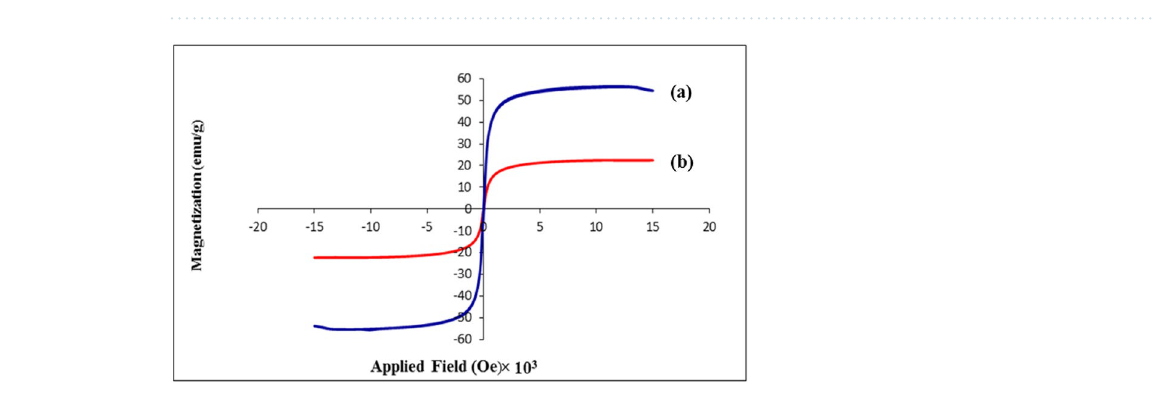
Figure 4. TEM images of Fe 3 O 4 @SiO 2 -creatine nanobiocatalyst in three different magnifications: ( a ) 150 nm, ( b ) 60 nm and ( c ) 30 nm.